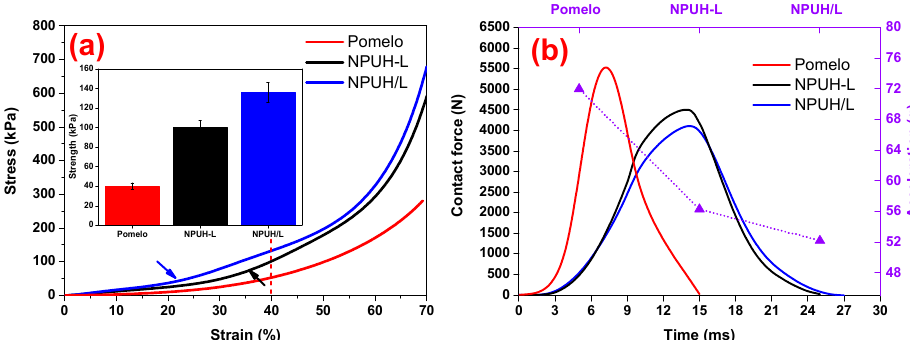
Figure 4. ( a ) Strain–stress curves of the pomelo peel and bionic composites; ( b ) Impact signal of the pomelo peel and bionic composites.